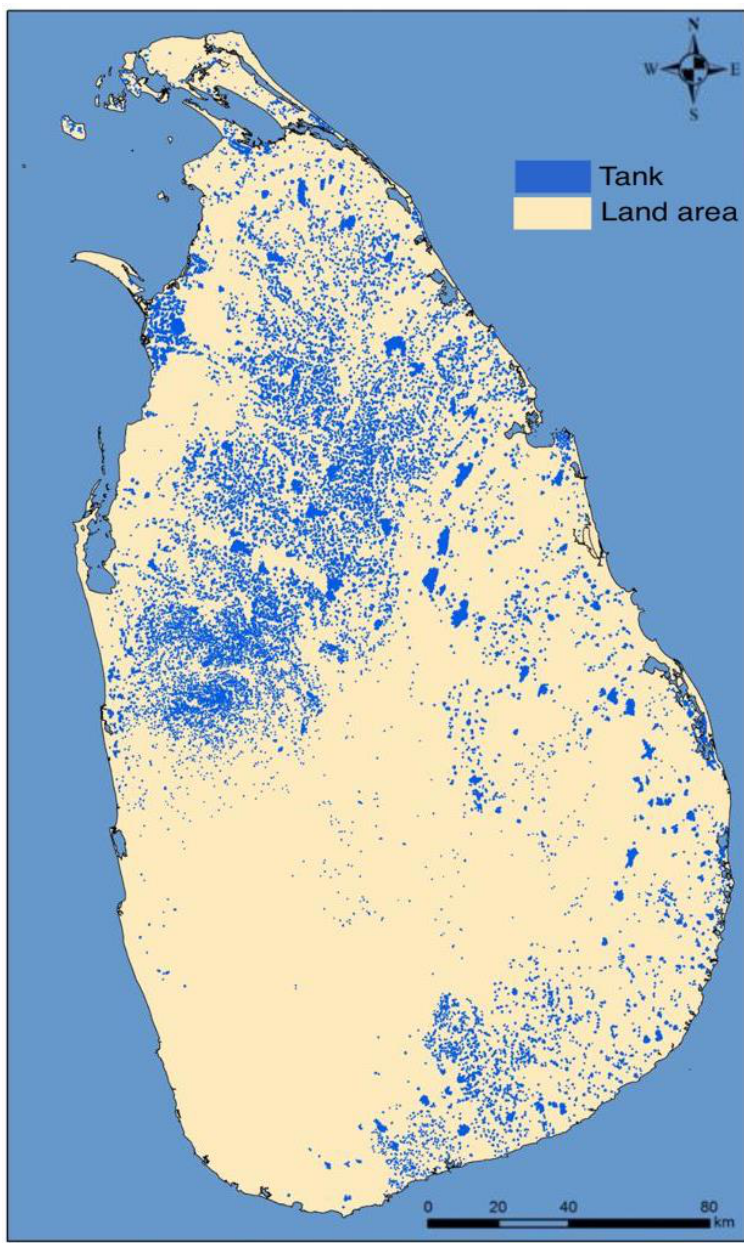
Figure 7. Irrigation tanks situation adopted from [56].